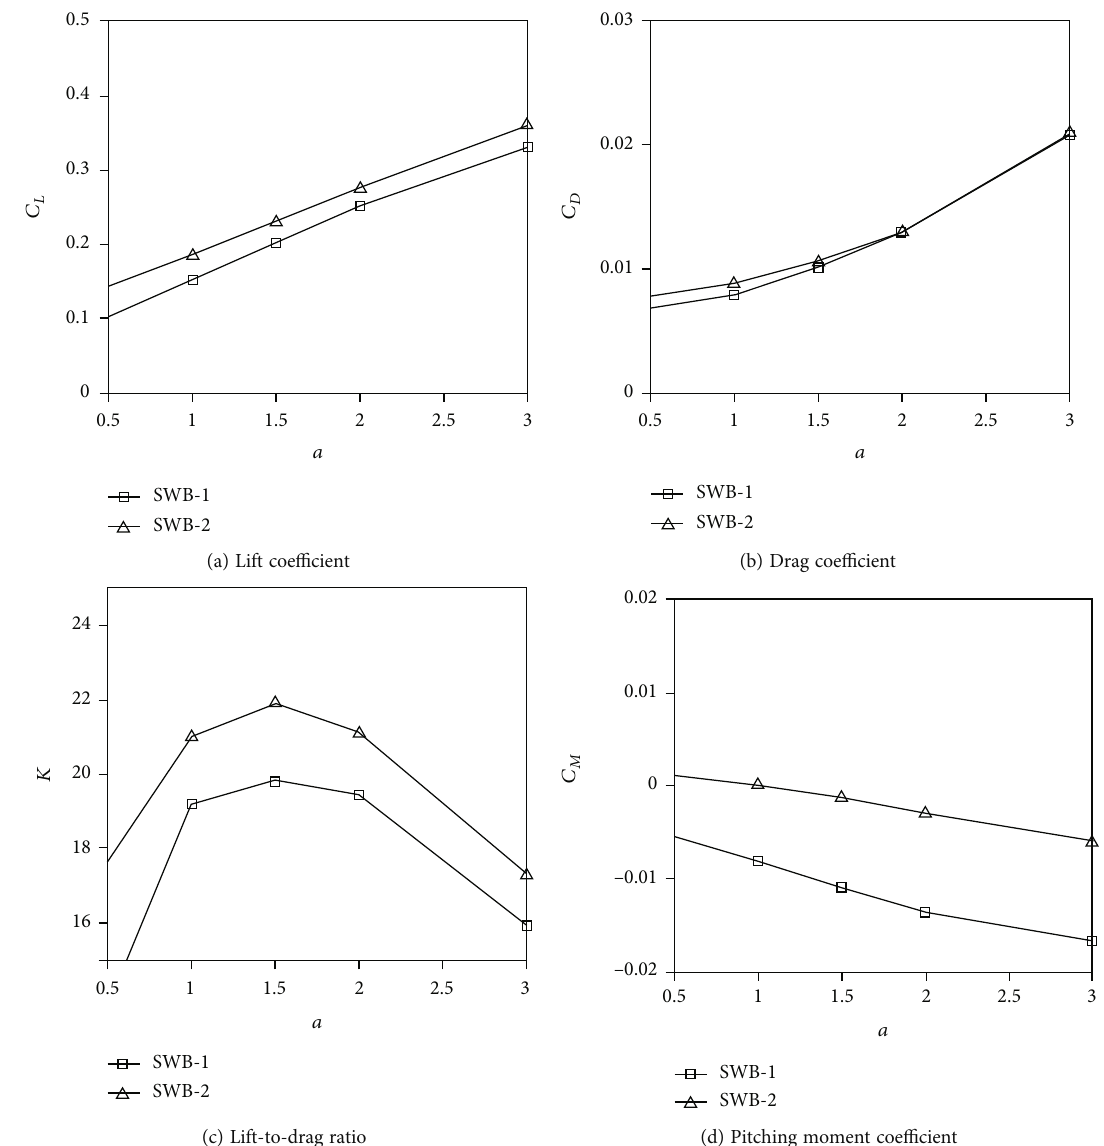
Figure 15: Cruise speed aerodynamic performance compared with SWB-1 and